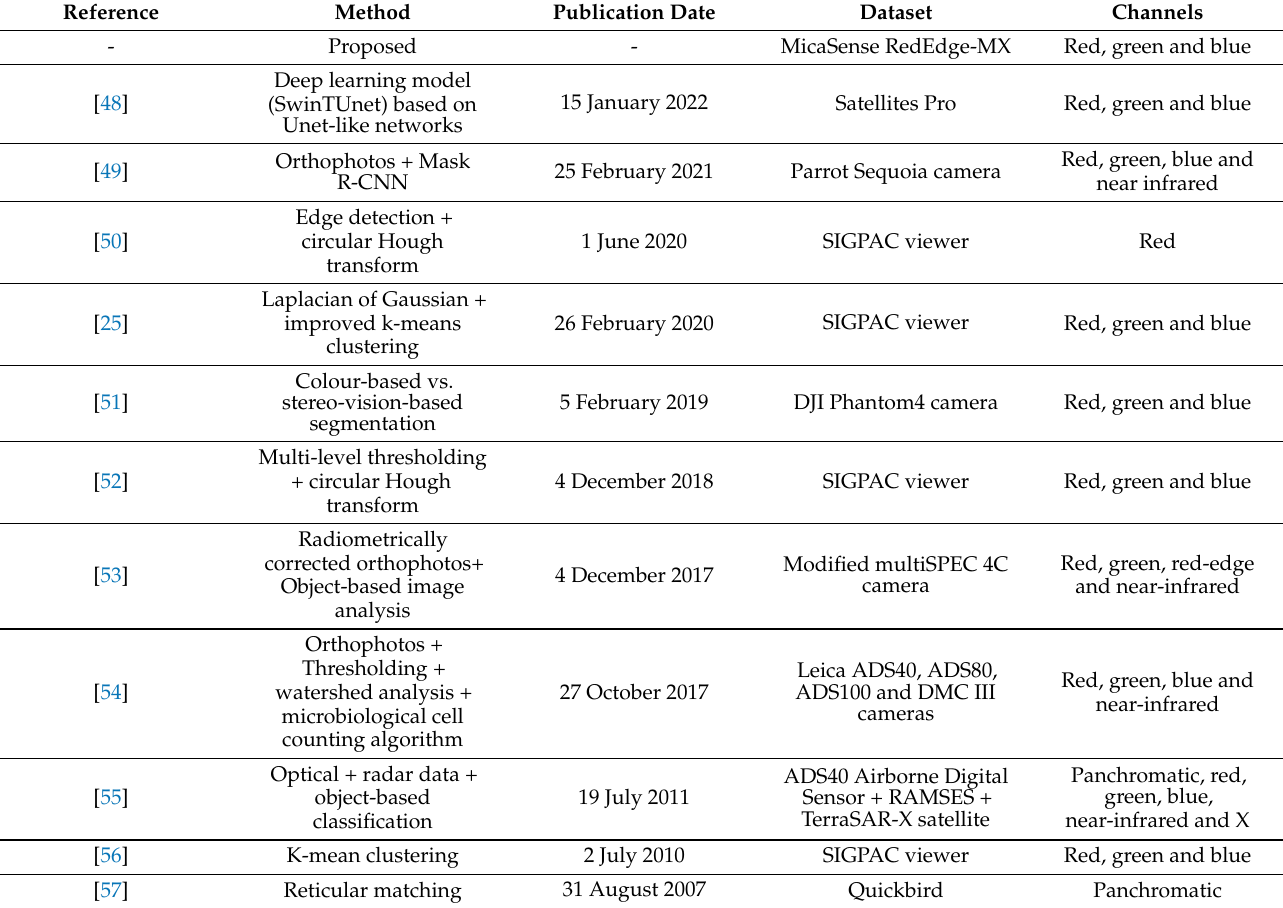
Table 5. Comparison of the results of this study with the results of other closely related articles that, although they do not explicitly use images of groves with thick plant cover on the ground, deal with the detection or segmentation of the olive tree canopies. The article reference, the method used, the publication date, where the data comes from (dataset) and what type of data is used (channels) are